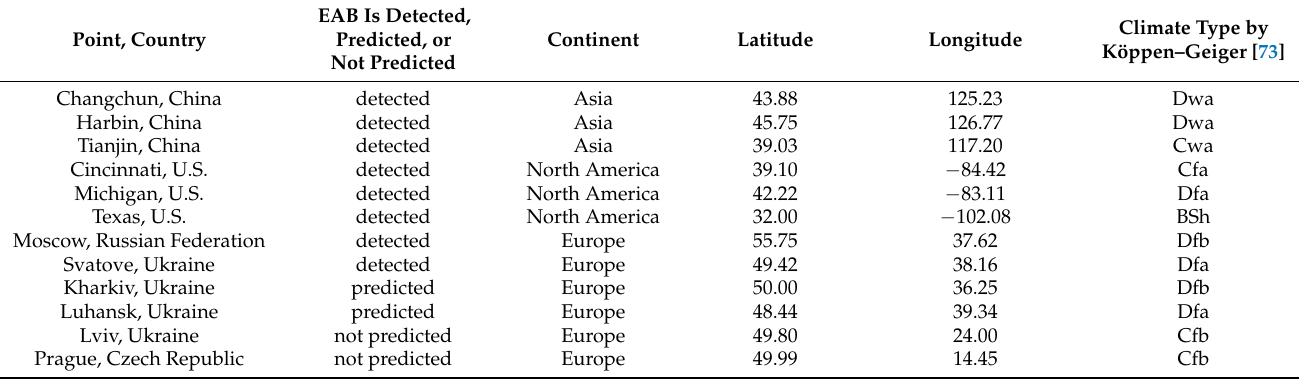
Table 1. Characteristics of the points for which climatic variables were analyzed in detail.